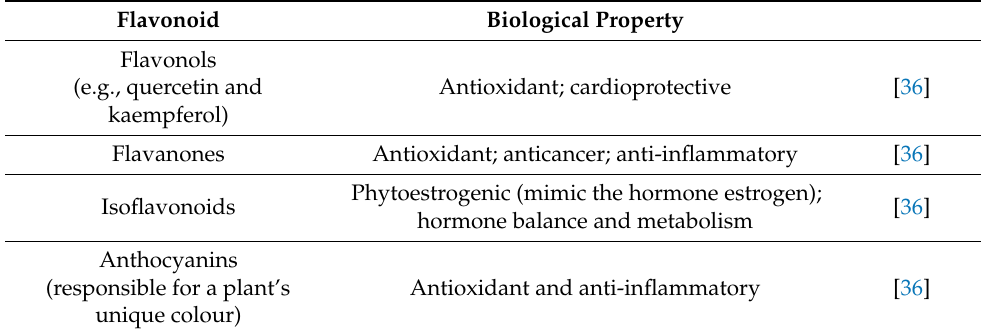
Table 5. The biological properties of some common classes of flavonoids.